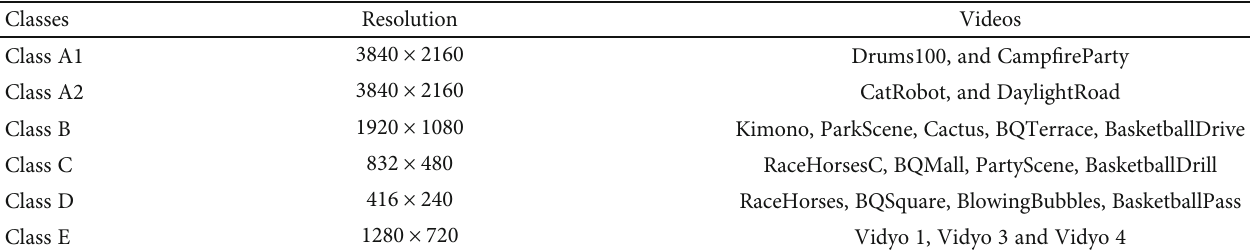
Table 1: Evaluated sequences.